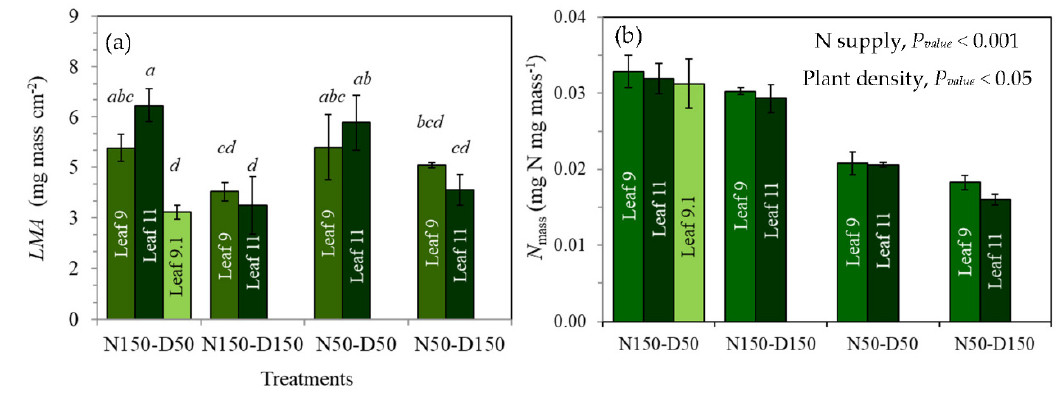
Figure 4. ( a ) Leaf mass per unit of area ( LMA ) and ( b ) N content per unit of mass ( N mass ), of leaves at different phytomer ranks in response to N supply and plant population density at 7 days before flowering (BBCH 62). Different letters indicate significant differences across treatments ( p < 0.05), and vertical bars indicate the standard error of means.